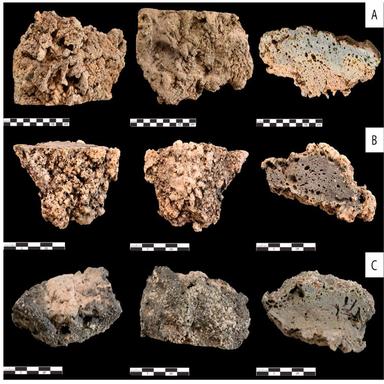
Examples of vitrified clay fragments discovered at Aardenburg (A) and Leffinge (B–C). On the left, the lightly modified outer surface of each fragment is shown and the highly vitrified irregular inner surface with dome-like protrusions of each fragment is visible in the middle. In the cross sections on the right, the progressive thermal transformation can be clearly observed. © C. Verhelst . (For interpretation of the references to colour in this figure legend, the reader is referred to the Web version of t